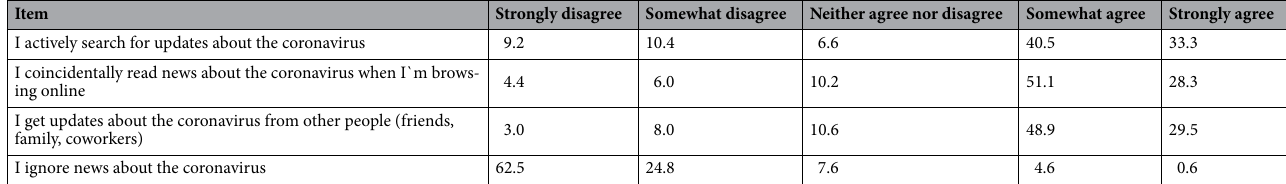
Table 4. Conditions of COVID-19 news encounters. Values represent percentages. N =